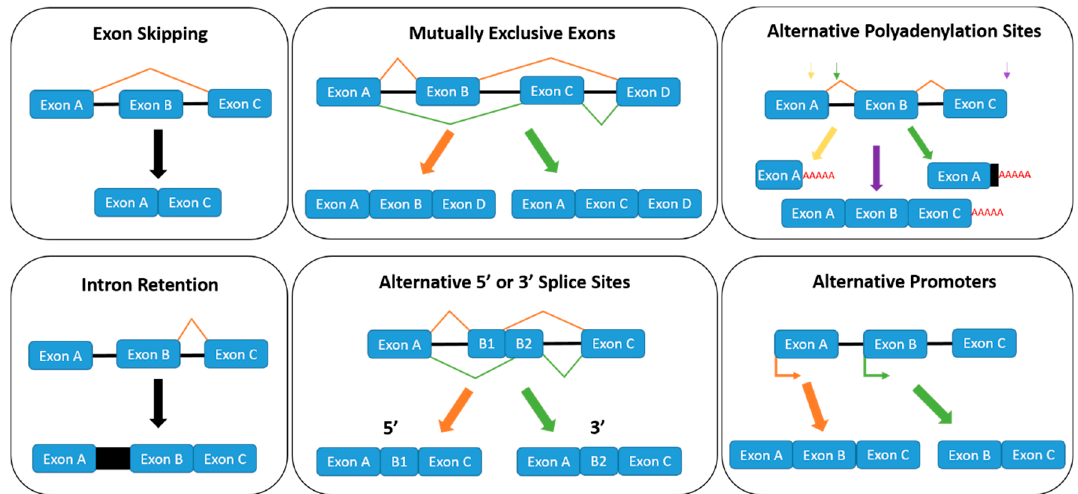
Figure 2. Different alternative splicing mechanisms; exon skipping, mutually exclusive exons, alternative polyadenylation sites, intron retention, alternative 5 ′ or 3 ′ splice sites and alternative promoters. The coloured splicing patterns correspond to the coloured arrows.